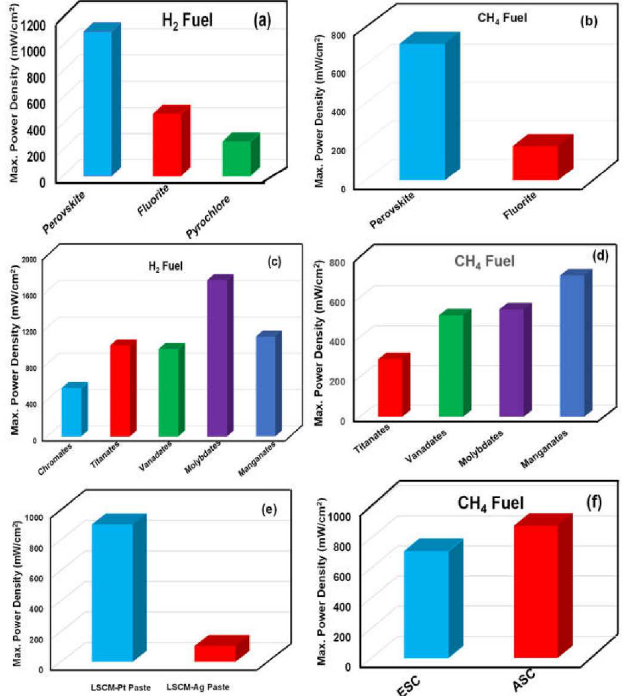
Figure 11. Performance of oxide anodes with the different crystal structure ( a ) in H 2 and ( b ) CH 4 ; with different composition in ( c ) in H 2 and ( d ) CH 4 ; LSCM ( e ) with different current collector pastes and ( f ) different